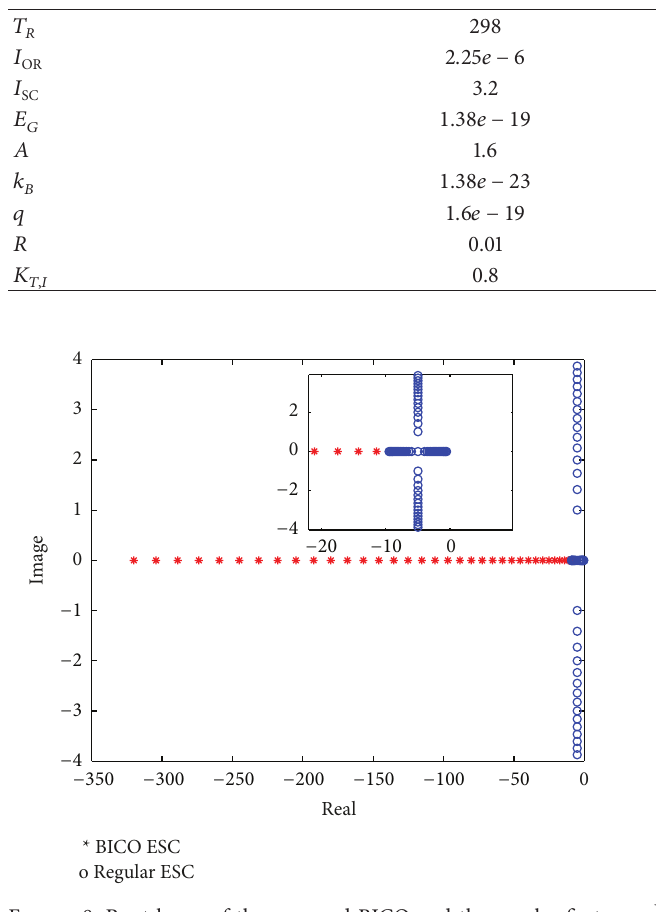
Figure 8: Root locus of the averaged BICO and the regular first- order low-pass filters.